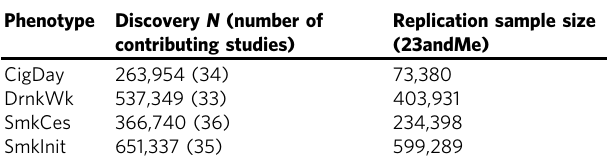
Table 1 Sample size for discovery and replication cohorts for smoking and drinking phenotypes in